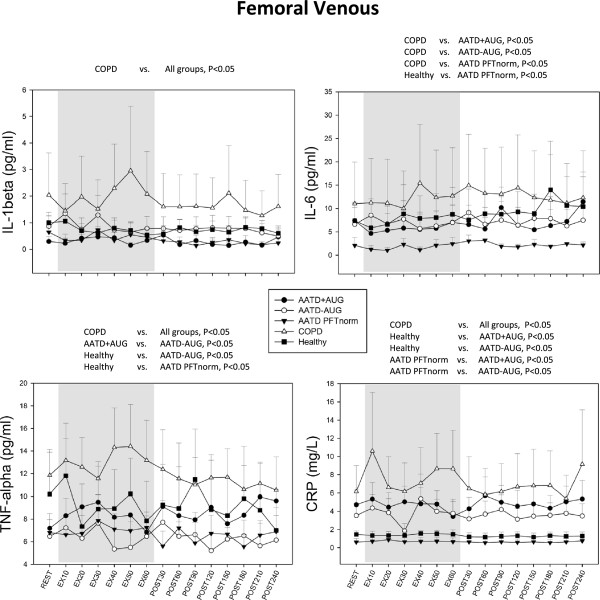
Femoral venous serum levels of cytokines from same conditions and subject groups in Figure1. Significant ANOVA main effect for group differences are shown above each graph. In all cases, significance is determined as p < 0.05.